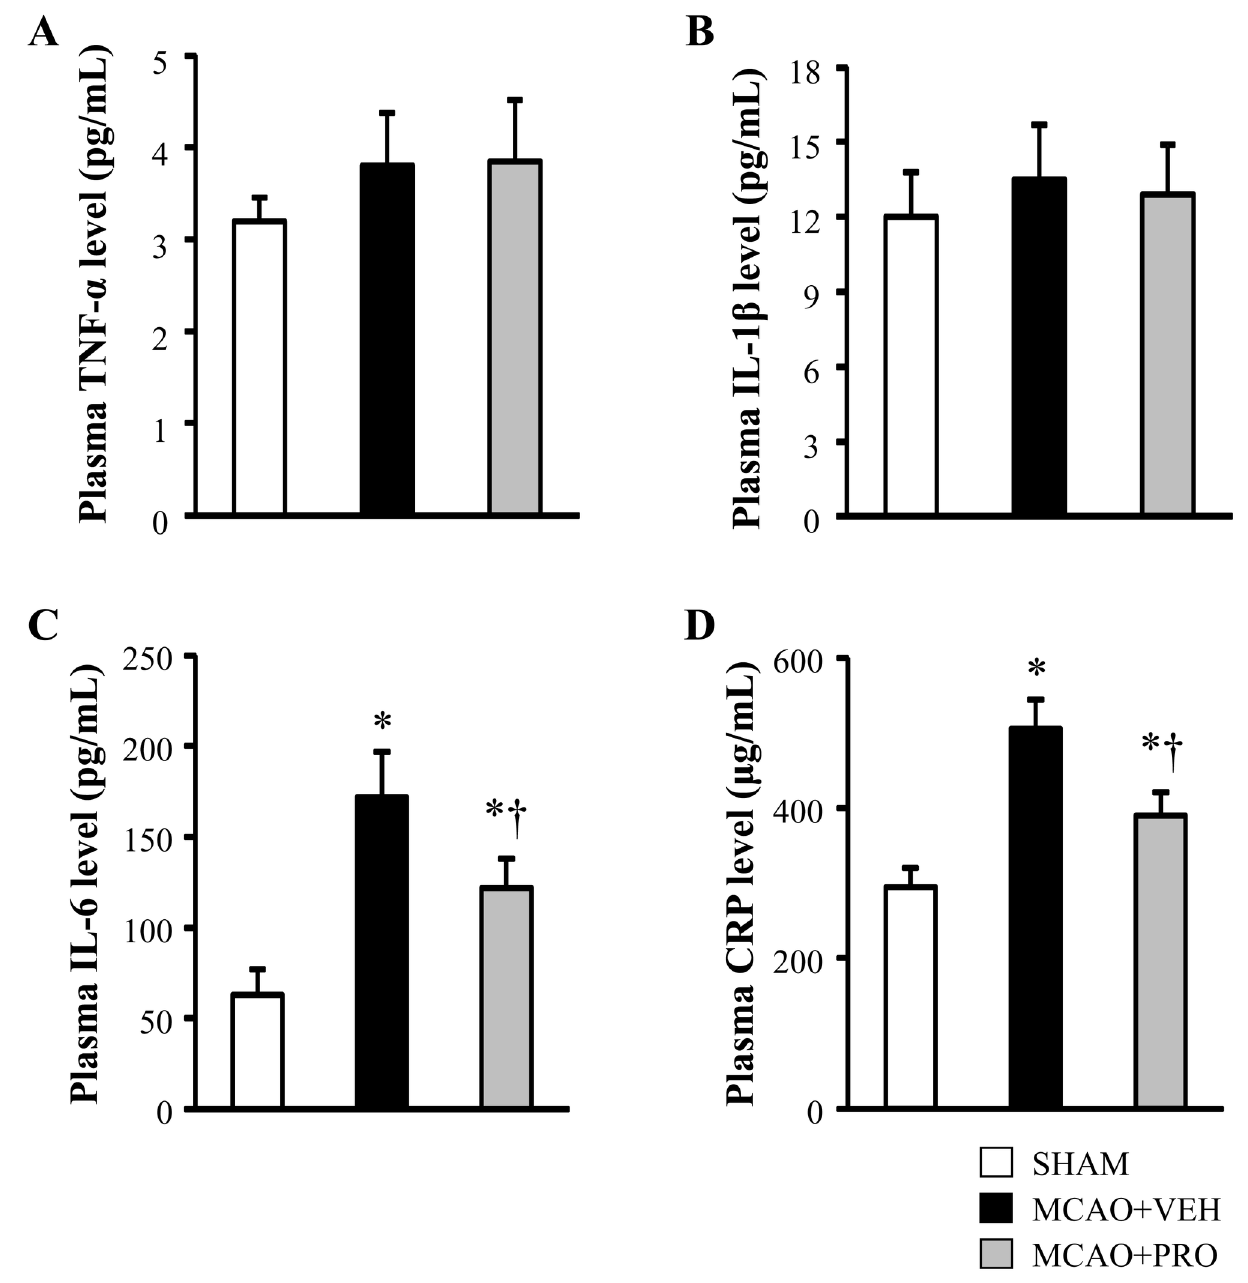
Figure 6. Plasma levels of proinflammatory cytokines TNF-α (A), IL-1β (B), IL-6 (C) and C-reactive protein (D) 24 h after MCAO in rats treated with VEH or PRO. SHAM rats without treatment were used as control. Values are mean ± SEM (n = 8 for each group). * P < 0.05 vs. SHAM, † P < 0.05 MCAO+PRO vs. MCAO+VEH.